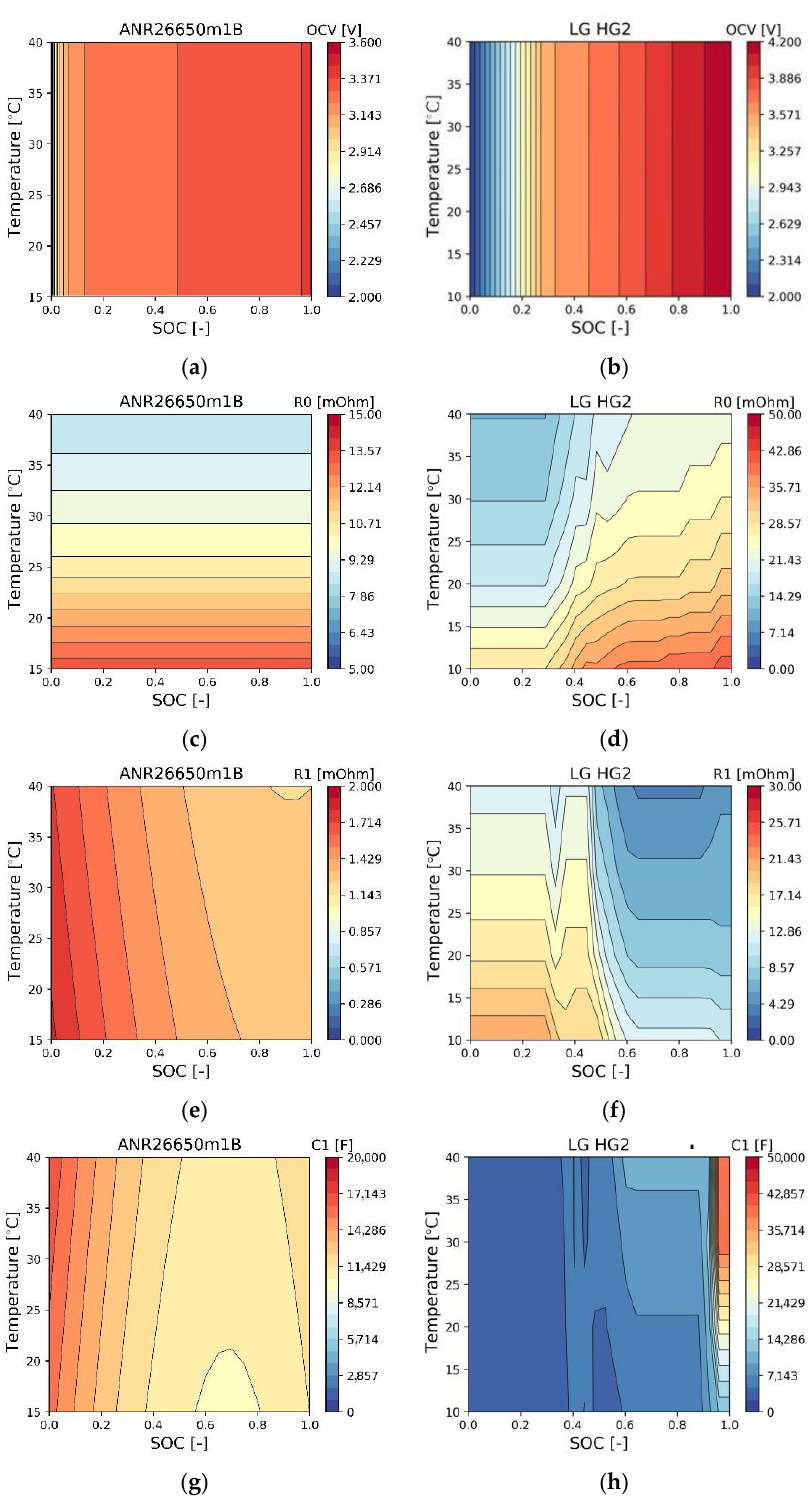
Figure 5. Three-dimensional maps for the parameters of OCV, R 0 , R 1 , and C 1 versus different ambient temperatures and state of charge. ANR LFP cell OCV ( a ), LG NMC cell OCV ( b ), ANR LFP cell R 0 ( c ), LG NMC cell R 0 ( d ), ANR LFP cell R 1 ( e ), LG NMC cell R 1 ( f ), ANR LFP cell C 1 ( g ), and LG NMC cell C 1 ( h